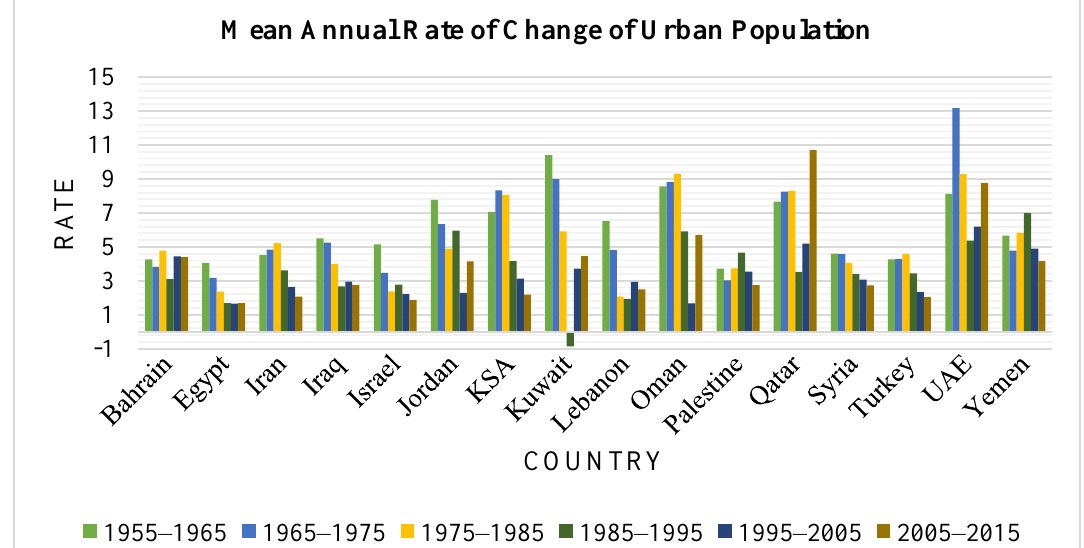
Figure 8. Decadal mean annual rate of change of urban population for each country. The data is acquired from the UN-Water [80] .